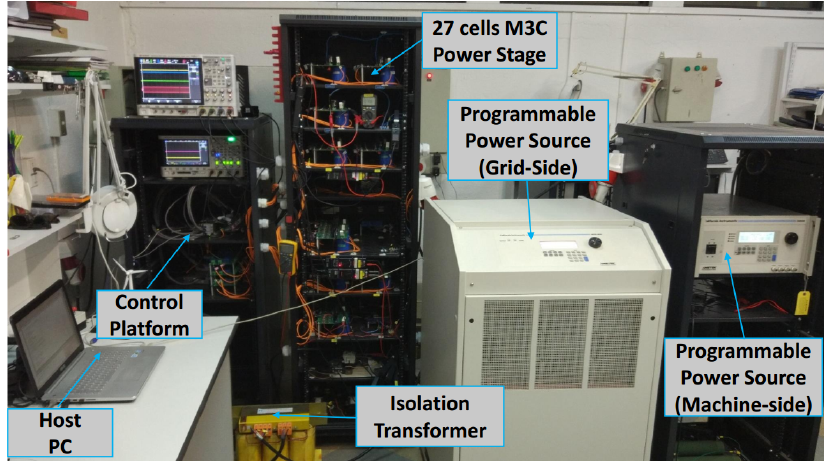
Figure 14. M 3 C Laboratory prototype.